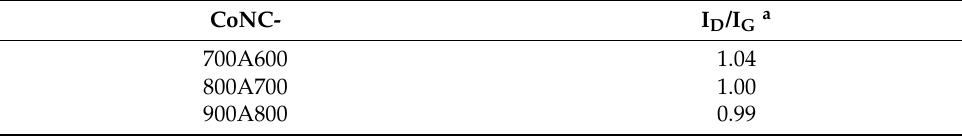
Table 1. Comparison of I D /I G of various cathode catalysts.